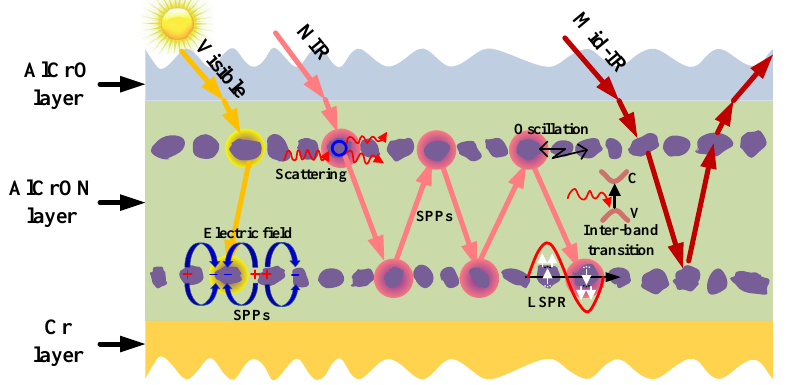
Figure 8. Schematic map of the selective absorbing mechanism behind the multilayer cermet coating with nanolaminates in the absorbing sublayer.